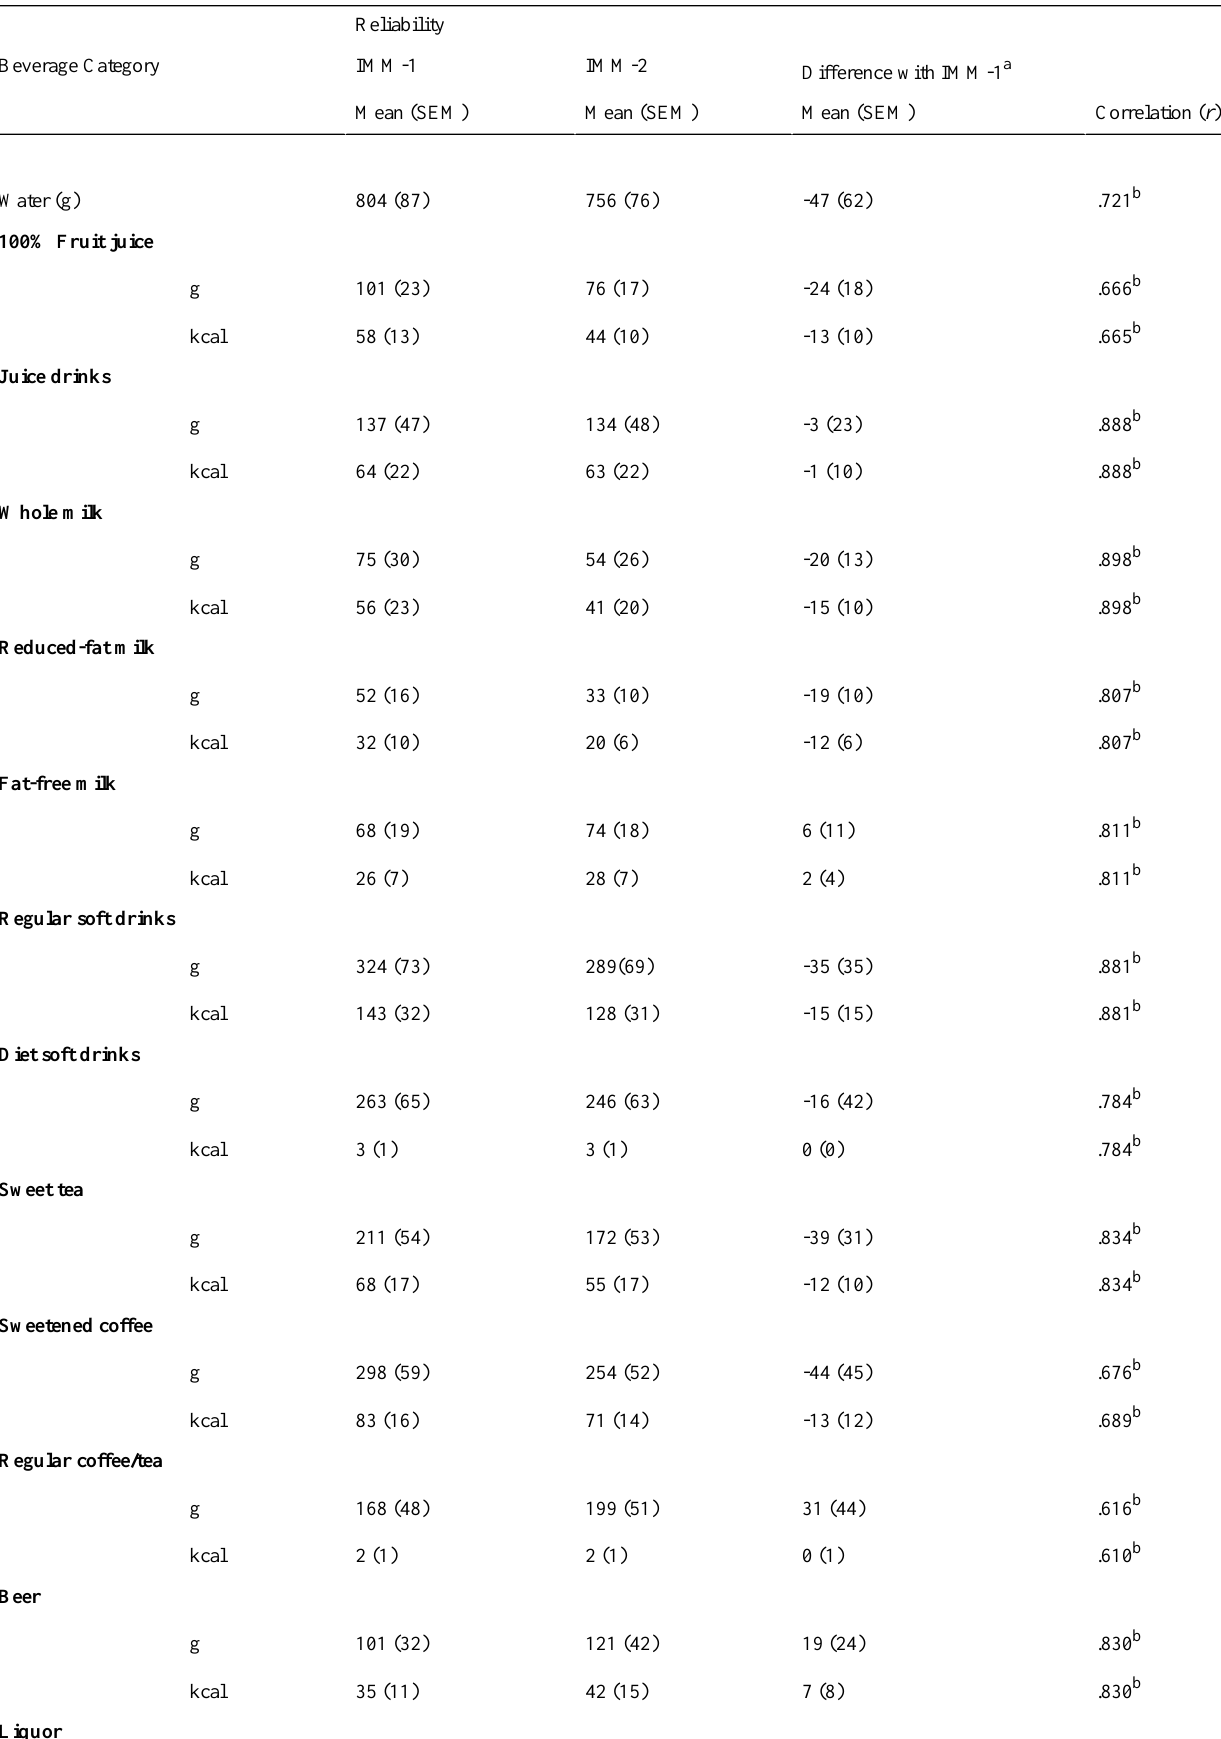
Table 3. Reproducibility of the IMM BEVQ-15: Comparison of the first and second IMM administrations.